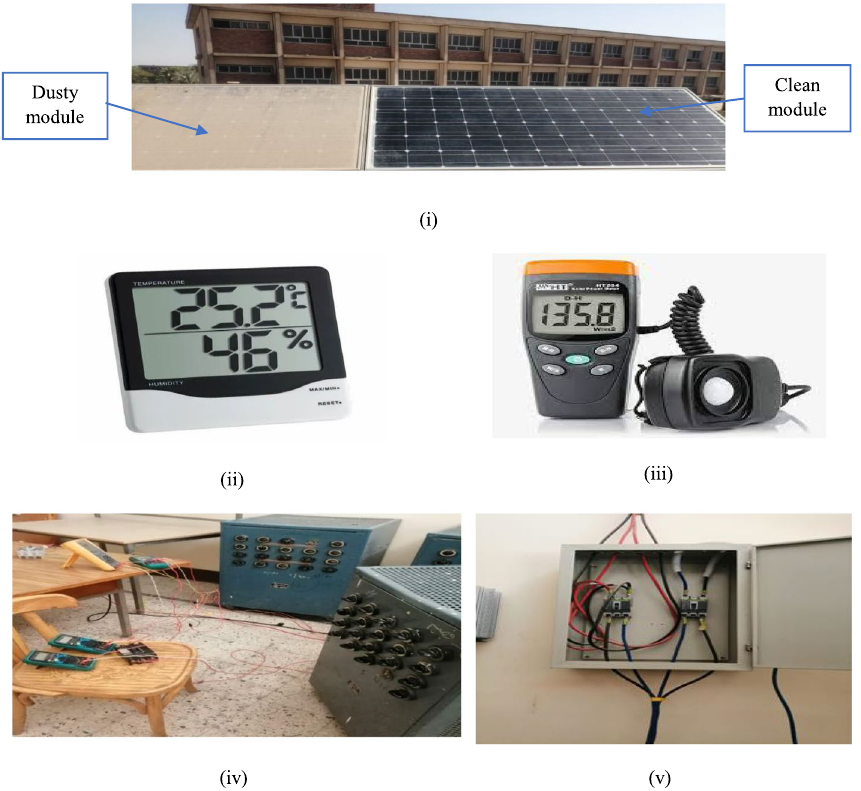
Fig. 4 Set up components for measuring I‑V characteristic of the PV module. (i) Two PV modules on the roof on of EE Department. (ii) Digital TFA Thermo Hygrometer for measuring ambient temperature. (iii) HT 204 solar power meter for measuring solar radiation. (iv) Voltmeter and ammeter instruments for measuring load voltage V and cell current of the PV module variable load resistances to change the output current. (v) + Cable extended from rooftop to indoor laboratory where measuring equipment (iv) is